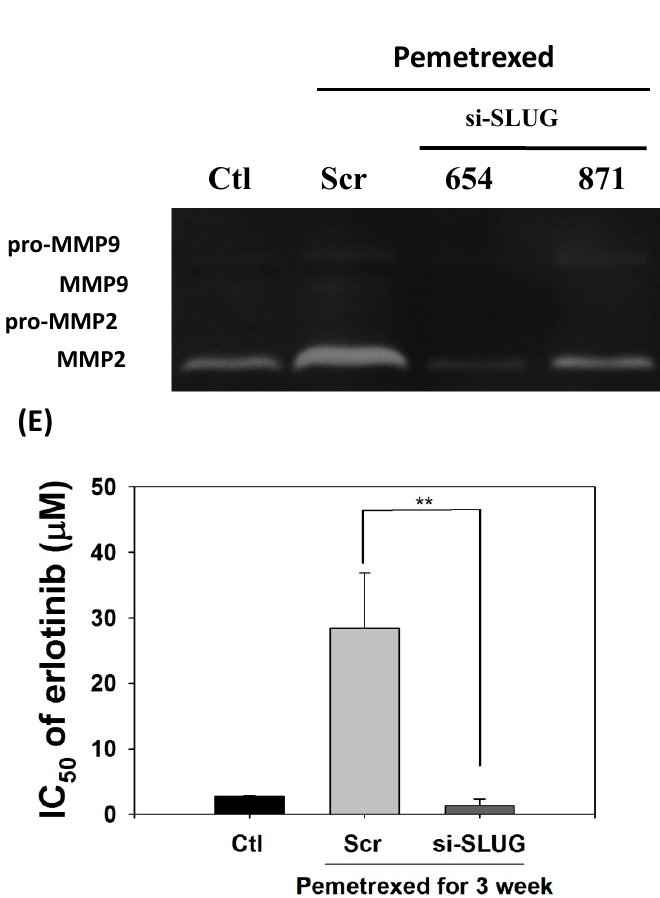
Figure 5. SLUG silencing suppresses invasiveness and reduces erlotinib resistance acquisition in CL1-0 cells. ( A ) Western blotting indicated that si-SLUG successfully silenced SLUG expression and could mitigate N-cadherin and SLUG expression in CL1-0 cells. ( B ) The invasiveness of cells treated with pemetrexed (30 ng/mL) was severely downregulated by SLUG silencing. The purple color represents invasive cells after the application of Liu’s stain. Scale bar (red): 100 μ m. ( C ) MMP1, MMP2, MMP7, and MMP9 gene expressions significantly decreased by SLUG silencing. Gene expression was determined through RT-qPCR in untreated CL1-0 cells (control) or pemetrexed-treated (30 ng/mL) CL1-0 cells, including scramble, si-SLUG 654, and si-SLUG 871. ( D ) Gelatin zymography showing that silencing SLUG expression reduces pemetrexed-induced gelatinase activity. ( E ) SLUG silencing abolished the erlotinib resistance of CL1-0 cells acquired from pemetrexed (30 ng/mL) treatment. Control (Ctl) cells were untreated CL1-0 cells. Scramble (Scr) and si-SLUG CL1-0 cells were treated with pemetrexed (30 ng/mL) for 3 weeks. * p < 0.05; ** p < 0.01.